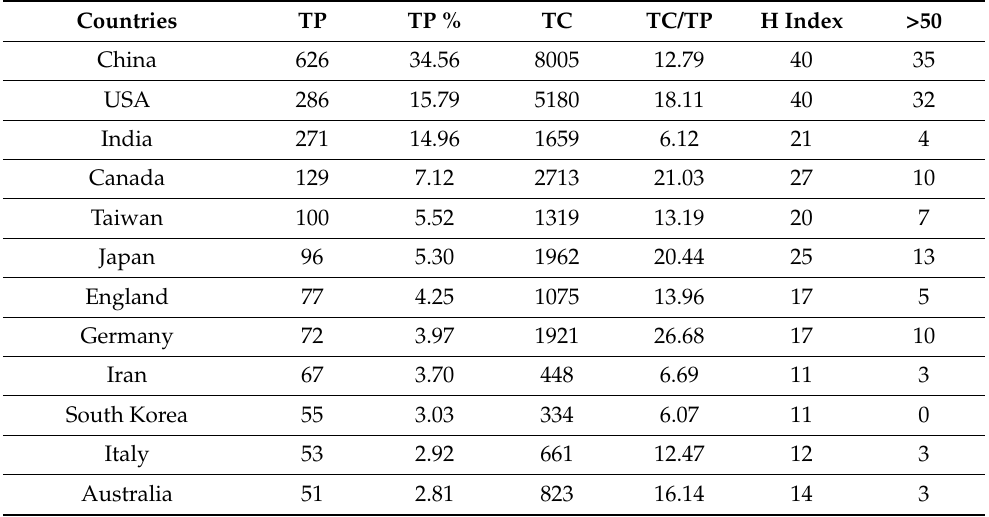
Table 4. Most productive countries for Fractional